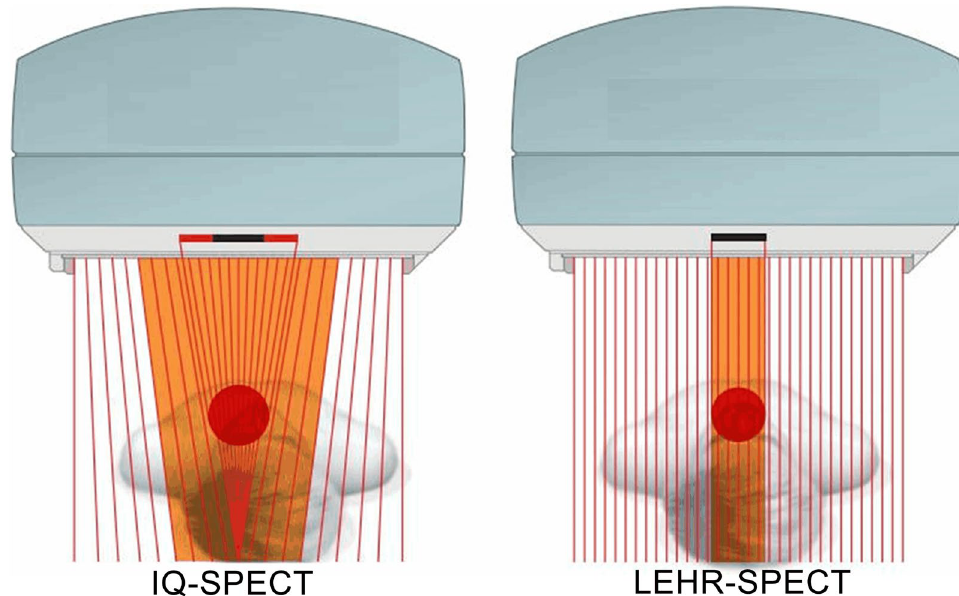
Fig. 1 Schematic diagrams of IQ single-photon emission computed tomography (SPECT) and low-energy high-resolution (LEHR)-SPECT